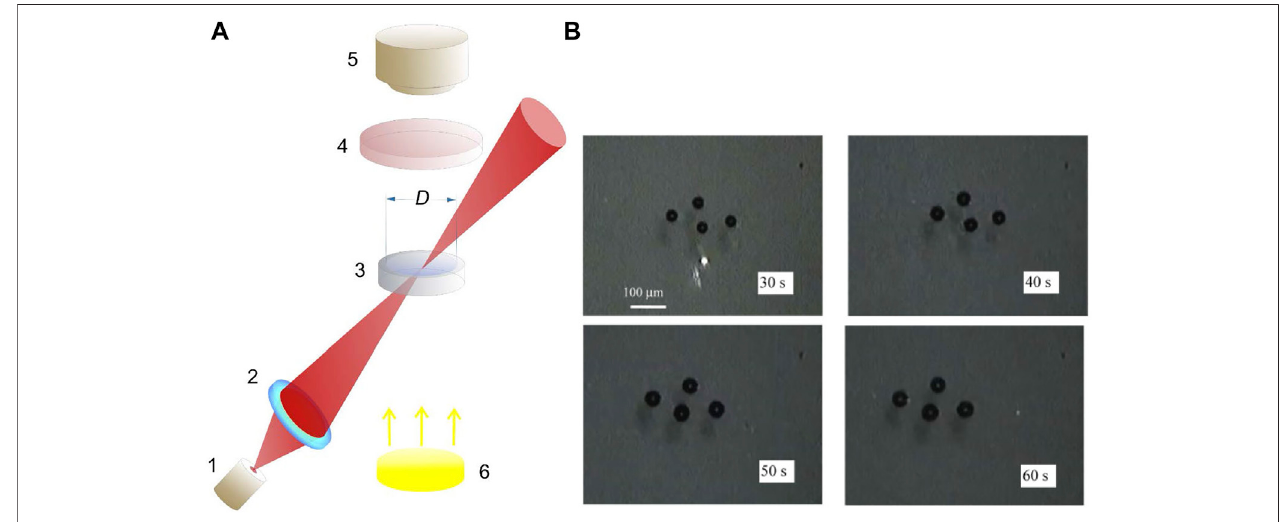
FIGURE 11 | (A) The experimental setup for the bubbles generation and observation: (1) IR laser, (2) objective, (3) cuvette with the water suspension of absorbing nanoparticles, (4) spectral fi lter to stop the IR radiation, (5) CCD camera, (6) white-light source for visible illumination; (B) Illustration of the behavior of the four-bubble ensemble in different moments of time; a gradual increase of the bubbles ’ sizes is